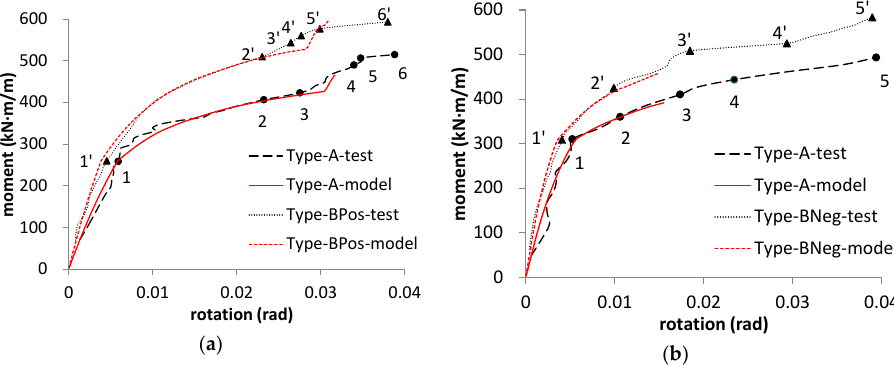
Figure 12. Evolution of the joint rotation with increasing bending moments: ( a ) positive cases; ( b ) negative cases.